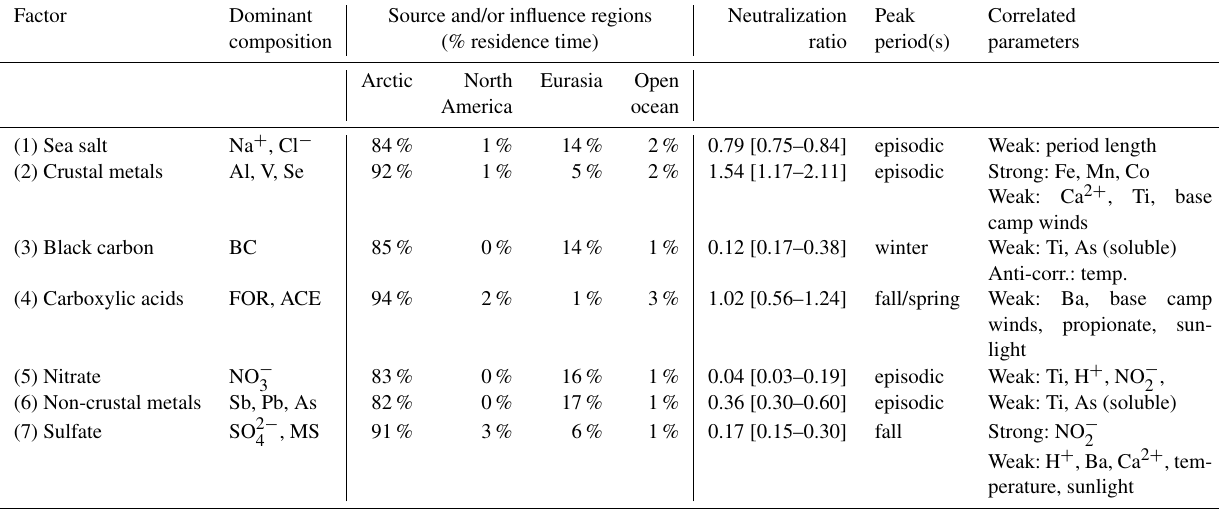
Table 2. Overview of factor